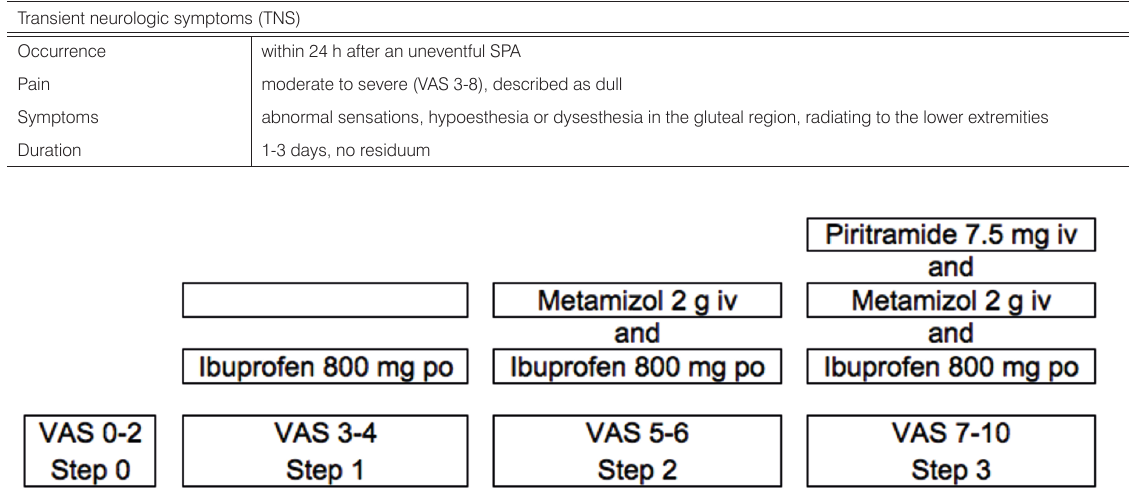
Table 1. Transient neurologic symptoms (TNS); these symptoms were used to detect TNS during the telephone interview and to differentiate them from usual back pain [ 3 , 5 , 6